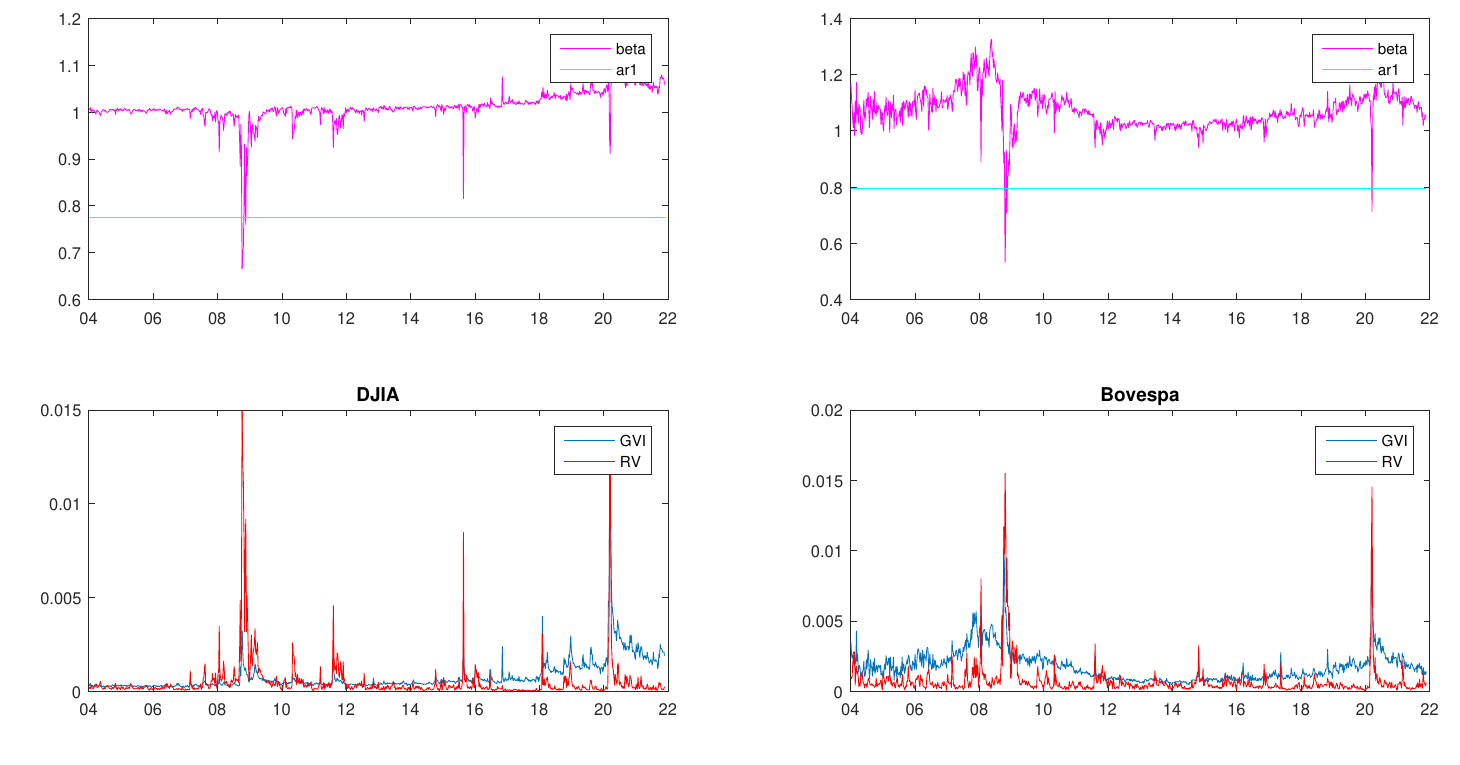
Figure 2. Time plot of coefficient estimates β t (beta) and the autoregressive coefficient (ar1), respectively, for the ES and AR(1) models ( top ) for DJIA ( left ) and Bovespa ( right ). Time-series of realized volatility and the corresponding GVI data ( bottom ) for DJIA ( left ) and Bovespa ( right